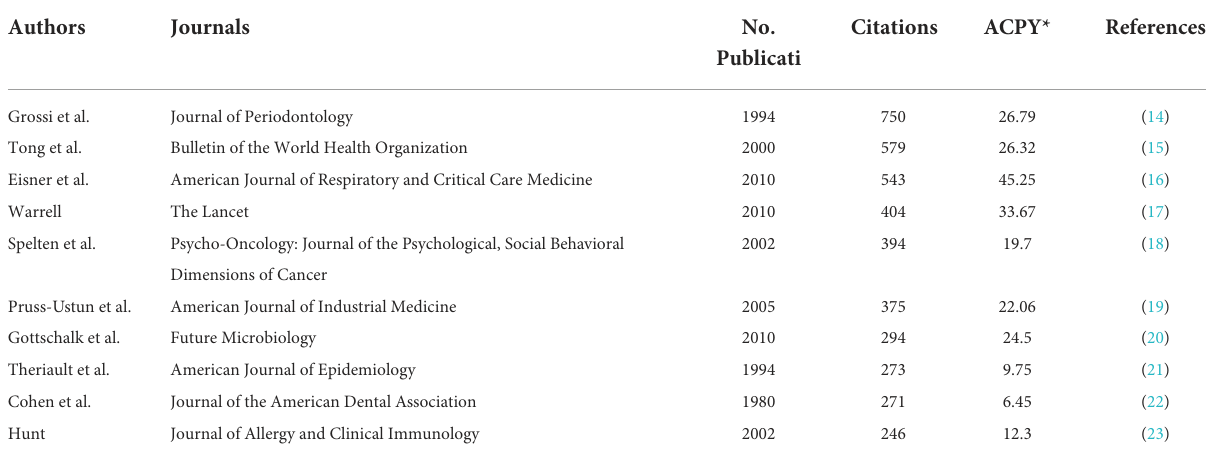
TABLE 1 The most cited studies in the field of occupational